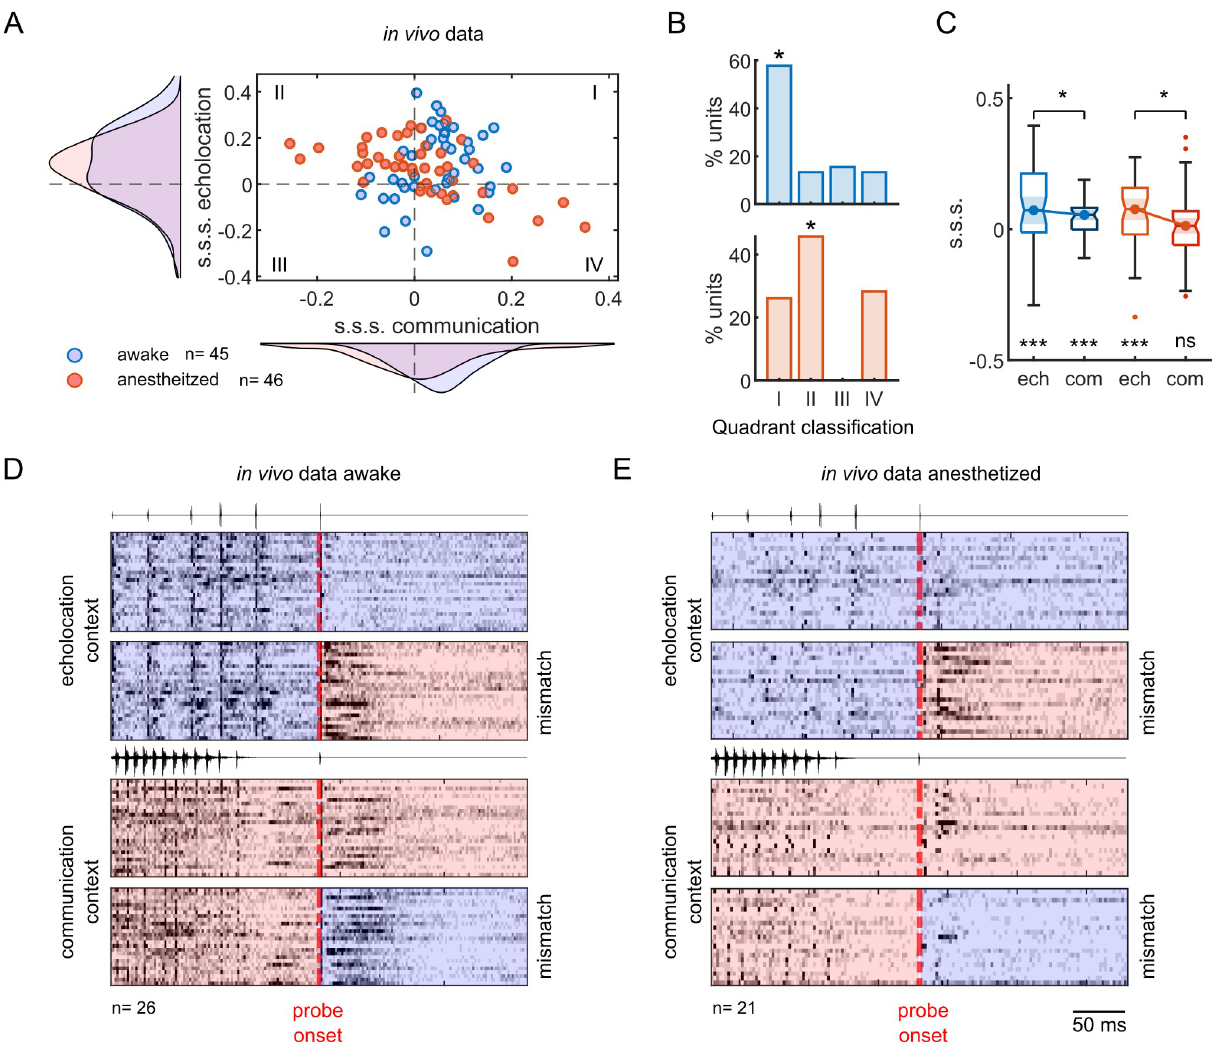
Fig 6. Anaesthesia decreases stimulus-specific suppression on probe-responses only after communication context. ( A ) Stimulus-specific suppression indexes (s.s.s.) calculated from awake (blue) and anaesthetized (red) preparations. Each circle corresponds to one unit ( n = 45 awake, n = 46 anaesthetized). The curves represent the distribution for a particular context. ( B ) Percentage of units per quadrant showed in “A” of units recorded in awake (top) and anaesthetized animals (bottom). Asterisks show the most represented quadrant on each preparation. ( C ) Boxplots of s.s.s. per context in awake and anaesthetized preparations. Significance level below the boxplot indicates differences against null distribution (one-sample Wilcoxon signed- rank test). Above, the comparison between contexts (paired test Wilcoxon signed-rank). ( D ) Normalised and averaged firing rate of units that corresponded to the most representative categories in “B” (quadrant I for awake and quadrant II for anaesthetized) aligned by probe onset. Blue background corresponds to echolocation sounds stimulation and red, to communication, either context or probe. ( E ) Same than in “D” but for the anaesthetized preparation. All the results correspond to a gap between context offset and probe onset equal to 60 ms. Data supporting the panels A-C can be found in the files “all_data.mat,” “pt_data.mat,” “all_dd.mat,” and “all_ce.mat” in “Ephys data” folder in https://gin.g-node.org/Luciana/anesthesia_ bats. The underlying codes for each panel are in the same